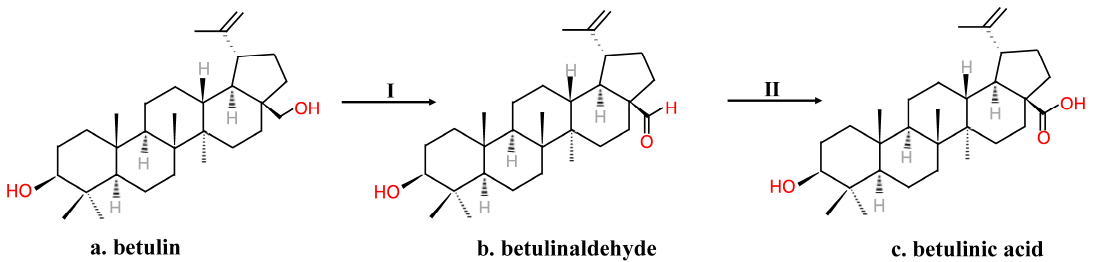
Figure 4. A short two-step procedure synthesizing betulinic acid from betulin. I. TEMPO, H+, electrochemical. II. Figure 3. Krasutsky’s multistep method of manufacturing betulinic acid.